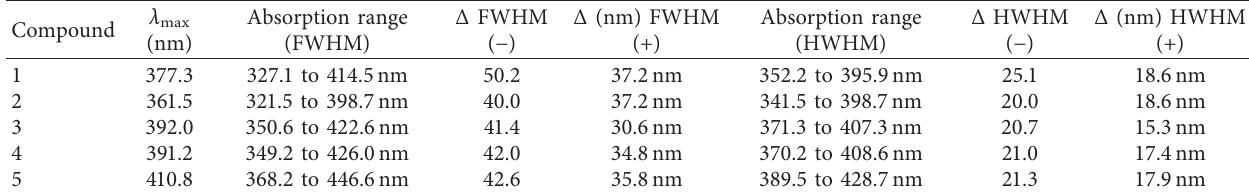
Table 2: Effective absorbance ranges of five cinnamaldehyde derivatives. FWHM is full-width at half maximum absorbance. HWHM is half- width at half maximum